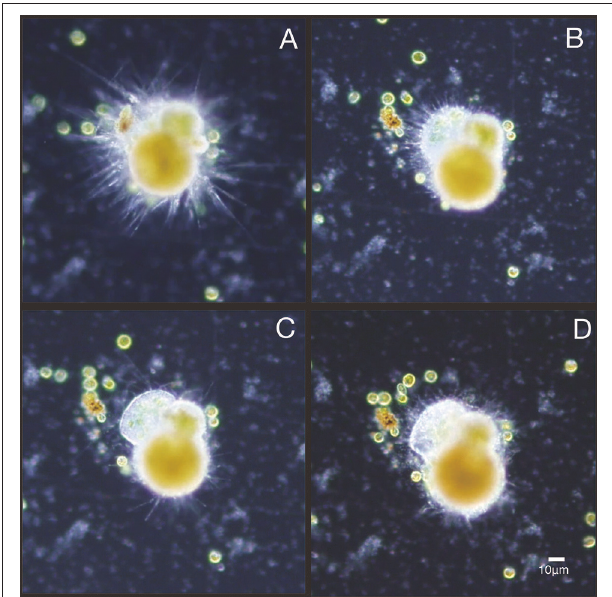
FIGURE 1 | Chamber formation of the studied species Ammonia “beccarii” . (A) Just before forming a new chamber, with many fine filamentous pseudopodia protruding from the existing test. (B) About 20min after shell formation started. (C) About 2h after shell formation started. (D) About 5h from the start of shell formation when chamber thickening takes